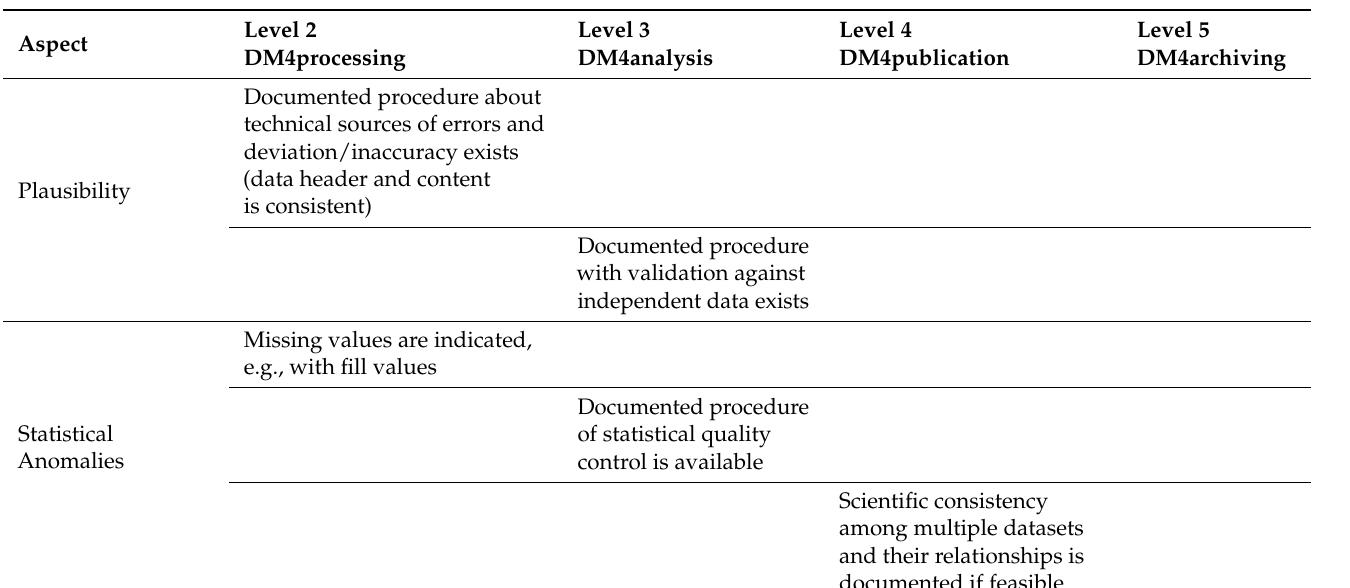
Table A3. Maturity matrix, criterion validation. Removed measures from [34] are not listed in the